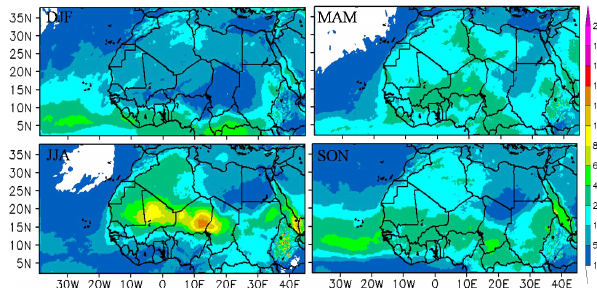
Figure 7. Seasonal mean wet deposition flux simulated by AL- ADIN (in gm − 2 ) over northern Africa averaged for the 2006–2010 period.